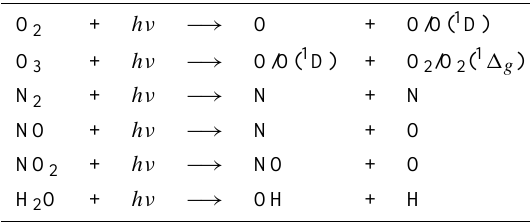
Table 3. The dissociation processes included in the SIC